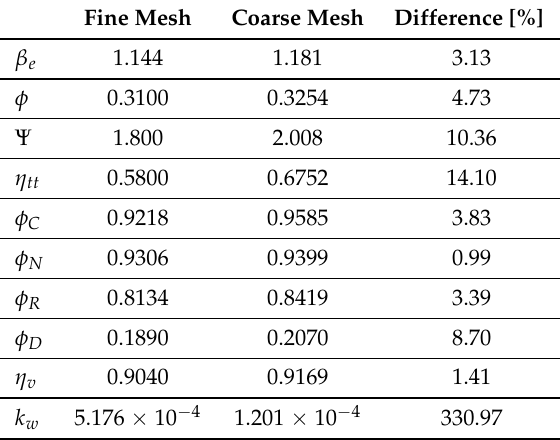
Table 6. Mesh sensitivity analysis.